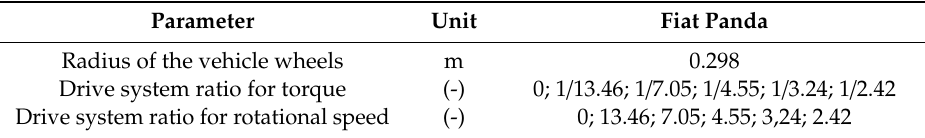
Table 5 identifies the values of those parameters used in the developed model. Table 5. Parameters for the ‘drive system’ module based on the manufacturer’s data.